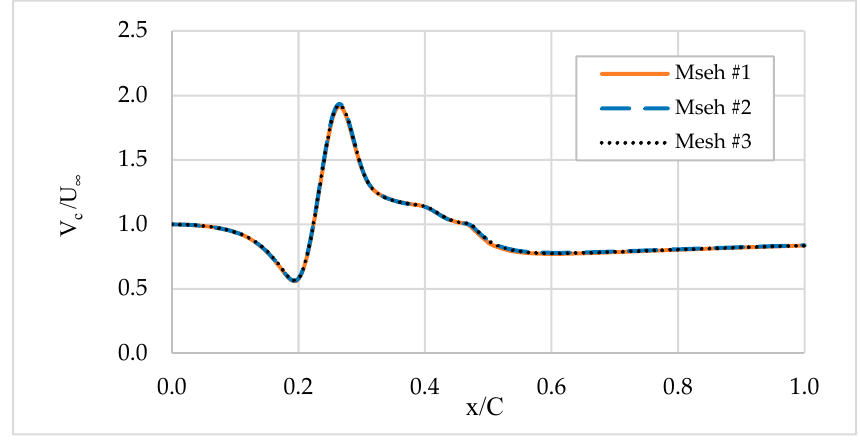
Figure 5. Normalized air velocity profile ( V c /U ∞ ) versus the normalized chord of the airfoil ( x/C ) based on the results from the three meshes at U ∞ = 3.0 m/s and 0.0° angle of attack. A set of two 3D-printed NACA 2424 airfoils with 200 mm chord length and 100 mm span (1:25 scale of the proposed system) was used to validate the CFD model results,